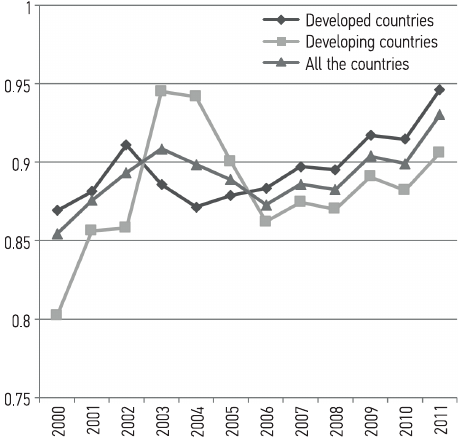
Fig. Average technical efficiency of developed and developing